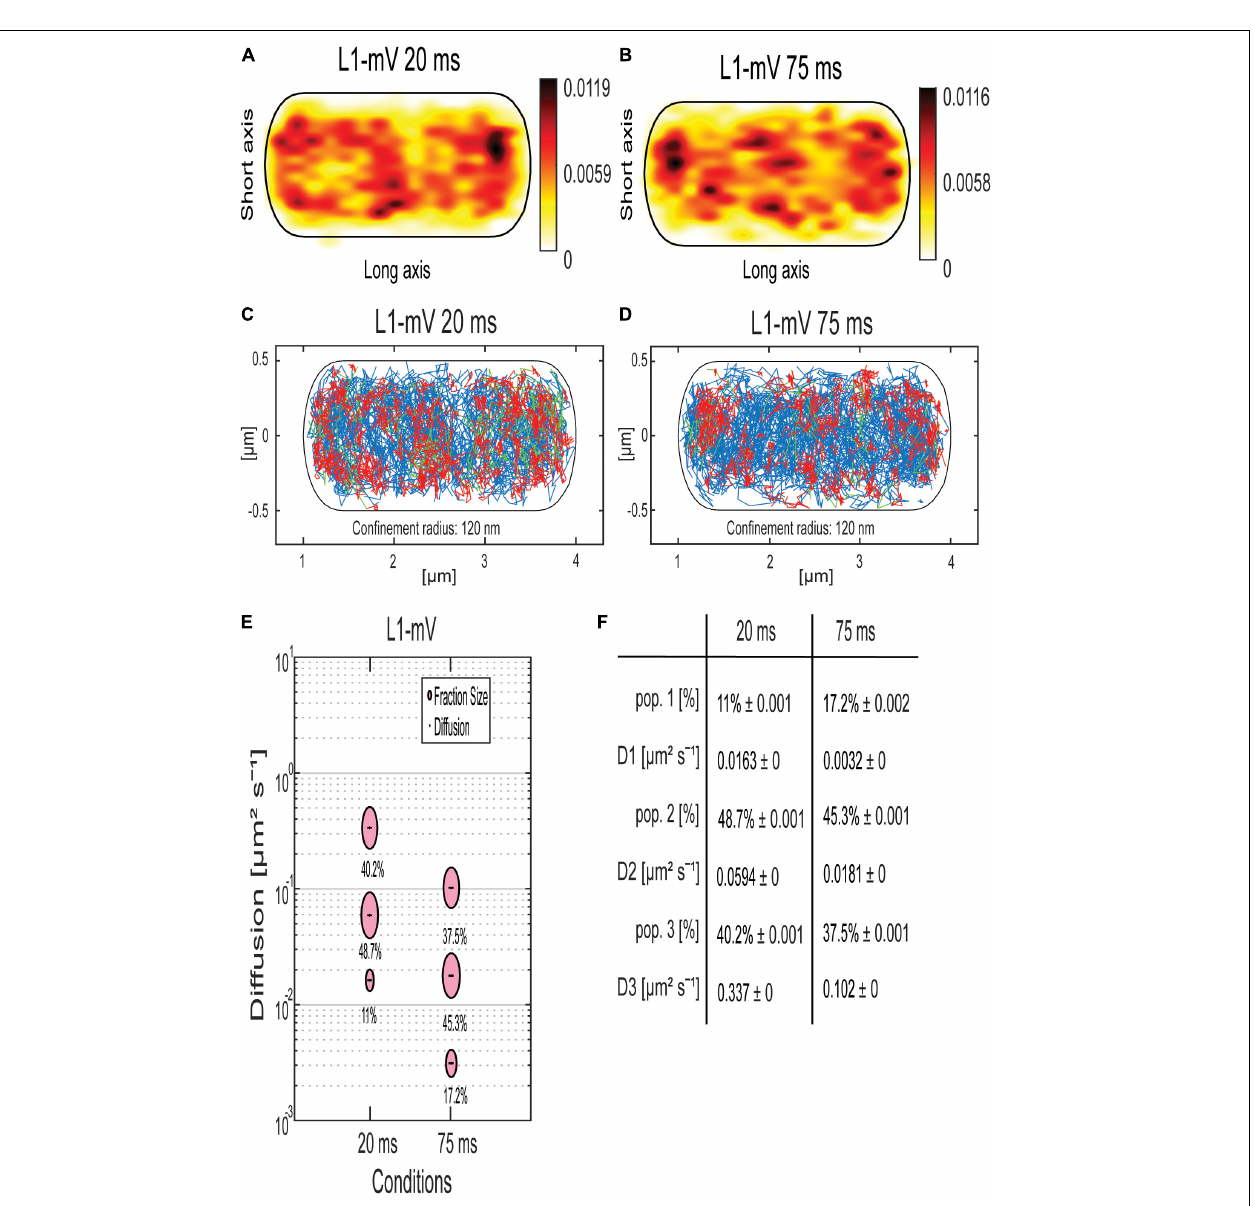
FIGURE 4 | Analyses of a ribosomal L1-mVenus protein fusion using SMT with 20- and 75-ms stream acquisition. (A,B) all tracks of L1-mVenus are projected into a standardized cell of 1 × 3 µ m. From white to red, low to high probability of localization for tracking with an exposure time of 20 ms (A) and 75 ms (B) . (C,D) Confinement maps. Blue represents freely diffusive tracks, red tracks showing confined motion within a 120-nm circle for a minimum of eight steps, and green tracks showing mixed behavior. (E) The bubble plot shows the size of the fractions; each bubble is proportional to the area of its corresponding diffusion coefficients. (F) Table showing population size and diffusion constants at different acquisition times. Squared displacement analysis was used for the determination of the diffusion constants and fraction